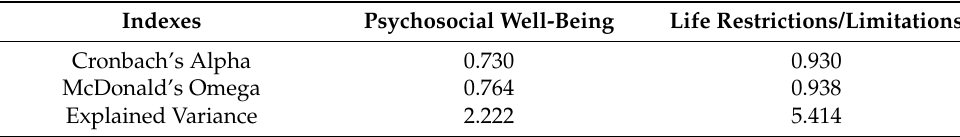
Table 6. Internal consistency of the OPQOL-Brief